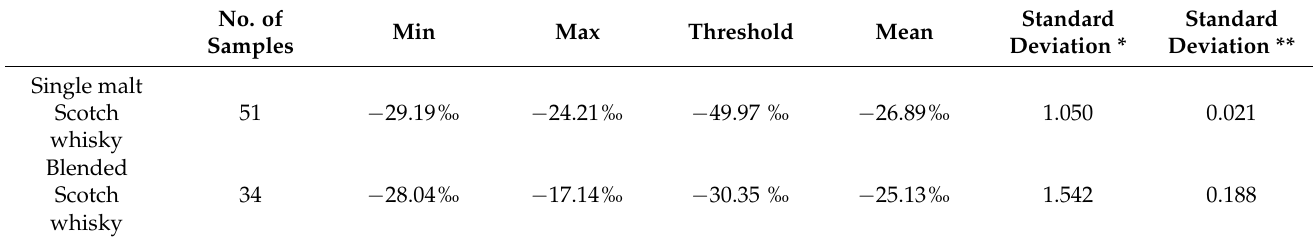
Table 2. Data descriptions of δ 13 C-ethanol data for authentic Scotch whiskies.